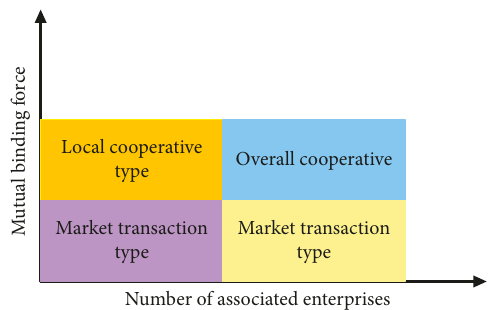
Figure 2: Classification diagram of agricultural industrial chain organization